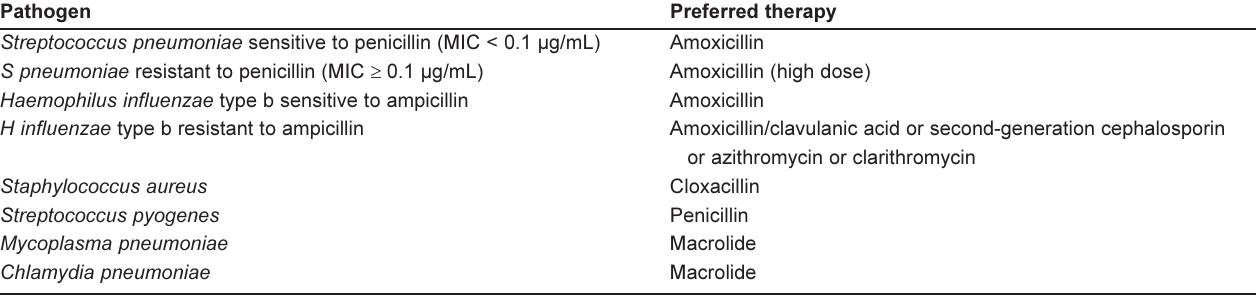
TABLE 4 Antimicrobial outpatient therapy for pediatric pneumonia by pathogen